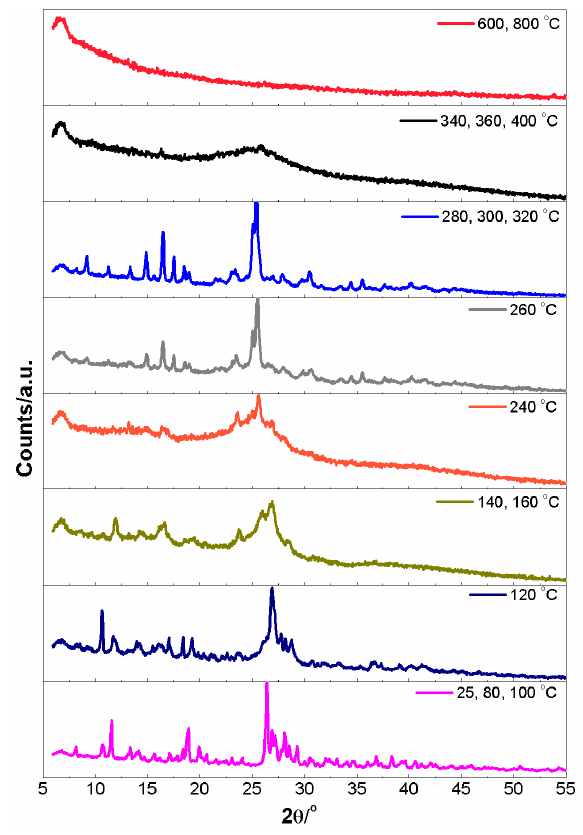
Figure 7. The powder XRD patterns of 1 after heating in the range of 25–800 °C in helium.